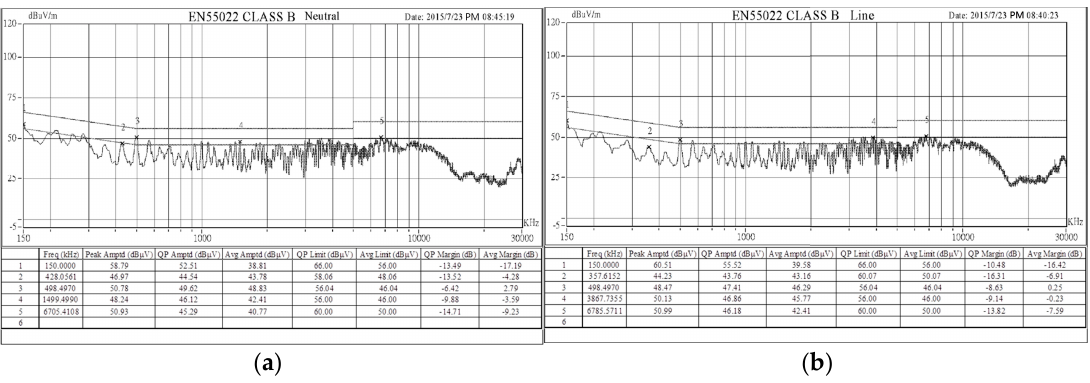
Figure 20. Conducted EMI measurements in the X-capacitor of 0.33 μ F (fixed frequency): ( a ) neutral; ( b ) line.